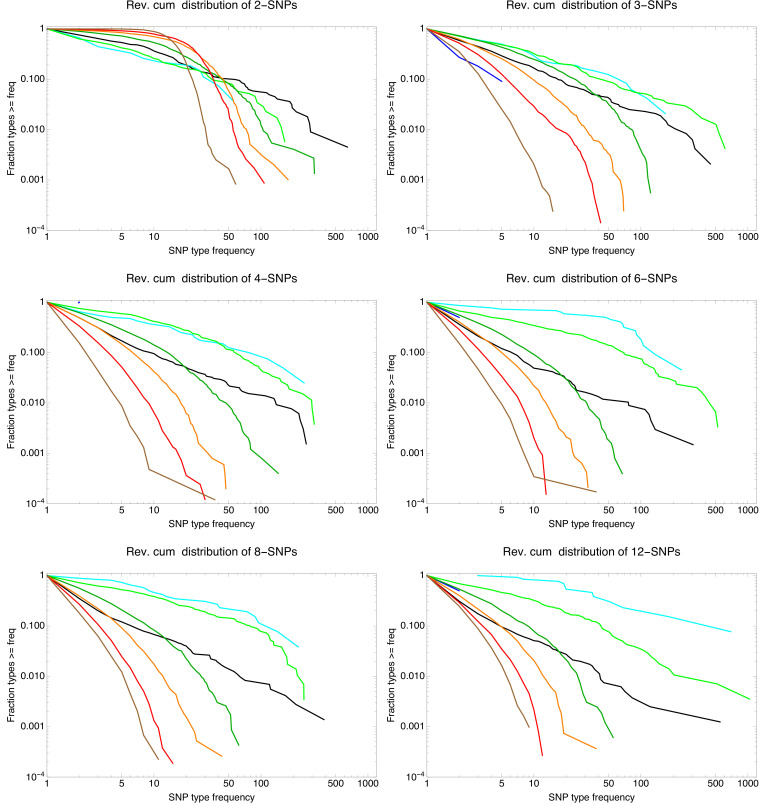
Example n-SNP distributions for E. coli (black lines) as well as for the simulations with different rates of recombination with ρ/μ=0 shown in blue, ρ/μ=0.001 in cyan, ρ/μ=0.01 in light green, ρ/μ=0.1 in dark green, ρ/μ=0.3 in orange, ρ/μ=1 in red, and ρ/μ=10 in brown.Each panel corresponds to the observed n-SNP distributions with the value of n indicated at the top of each panel. All axes are shown on logarithmic scales.